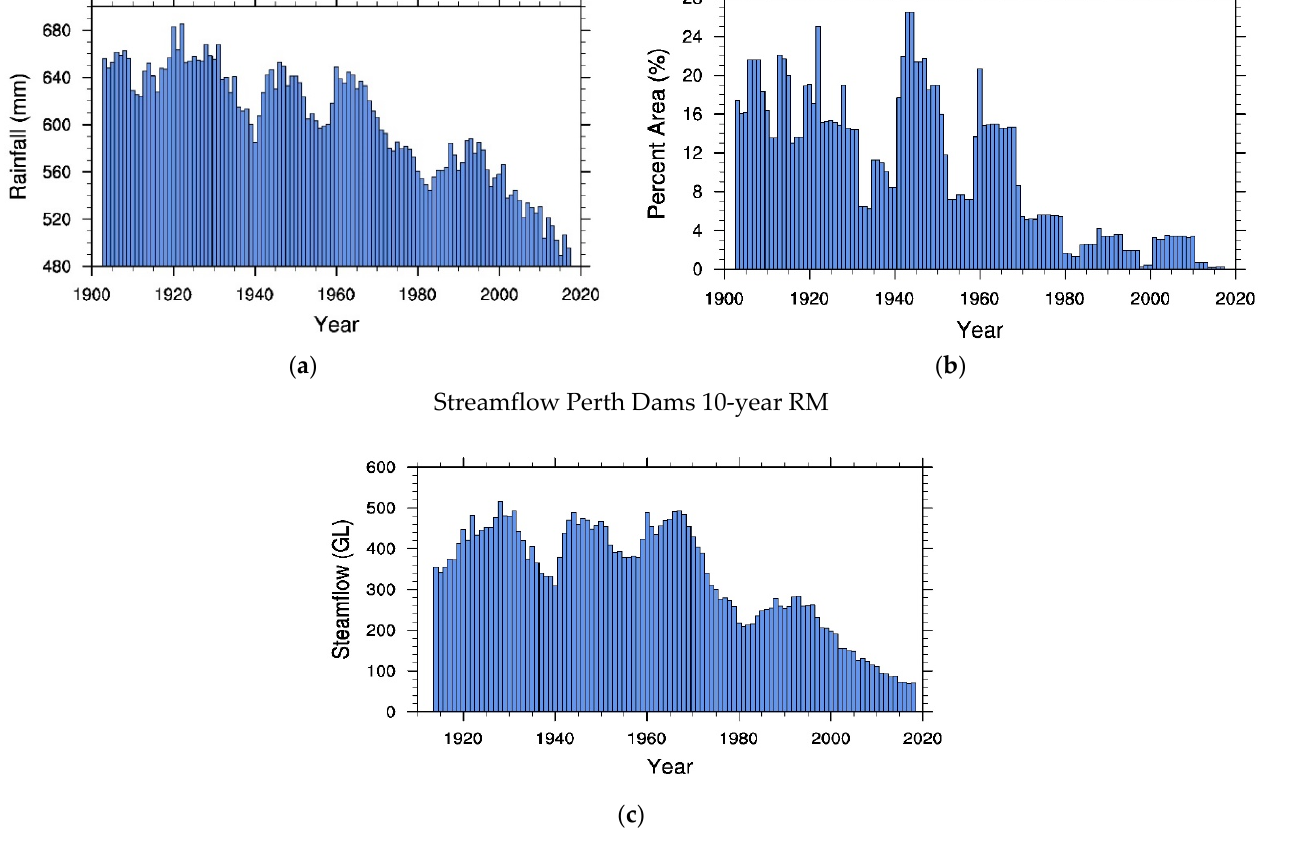
December streamflow into Perth dams and percentage area of SWWA with SWS rainfall in decile 10